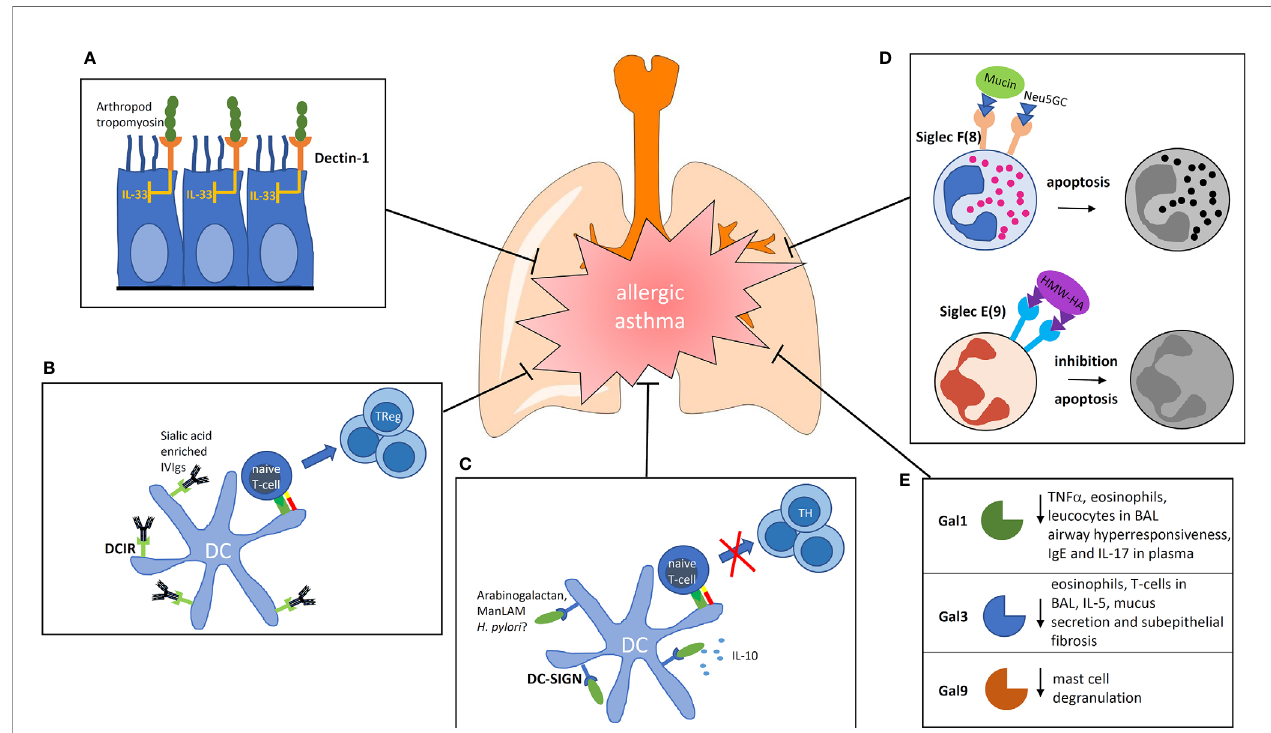
FIGURE 1 | Impact of carbohydrate recognition receptors and their ligands on the modulation of allergic in fl ammation. (A) Binding of arthropod tropomyosin to Dectin-1 on airway epithelial cells inhibits IL-33 release. (B) DCIR is known for its inhibiting signaling properties. If sialic acid-rich antibodies are bound by DCIR on DCs they are able to induce regulatory T cells. (C) Ligation of DC-SIGN can induce prolonged IL-10 production. The ligand arabinogalactan reduces the activation of NF k b and T-cell stimulatory capacity of human DCs. (D) Siglecs are membrane spanning receptors with signaling properties. Siglec F signaling induces apoptosis of eosinophils, Siglec E inhibits neutrophils. (E) Galectins are secreted proteins which bind to the glycocalyx of cells. In the group of galectins, three members are known to lower the allergic response by different mechanisms. BAL, broncho alveolar lavage; Gal, Galectin; ManLAM, mannosylated Lipoarabinomannan; IVIg, intravenous Immunoglobulins; HMW-HA, high molecular weight hyaluronan; Neu5GC, N-Glycolylneuraminic